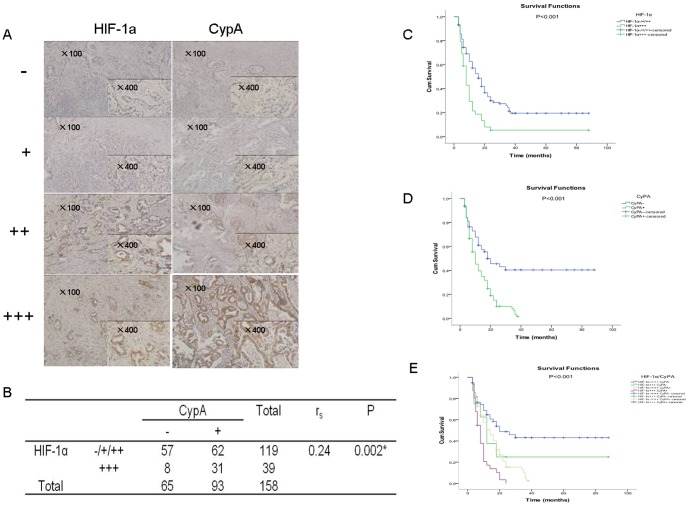
Validation of expression of HIF-lα and CypA in PDAC tissues and analysis of the clinical significance.
A. The IHC results of HIF-lα and CypA. CypA protein expression was significantly correlated with HIF-lα, as detected by immunohistochemical staining on PDAC. Left panels: various expression levels of HIF-lα protein. Right panels: expression of CypA protein of the same samples in the adjacent section. B. Cross tabulation of HIF-lα and CypA expression levels in 158 cases of PDAC. Expression of CypA was correlated with HIF-1α (P = 0.002). C. The survival analysis of HIF-lα IHC results. PDAC patients (n = 158) with mild positive HIF-lα protein expression (−/+/++, n = 119) had significantly better total survival than those with strong positive expression (+++, n = 39). HIF-1α expression was prognostic for overall survival. The two- and three-year survival rates were 25.2% and 13.4%, respectively, in patients with mild HIF-1α, but decreased to 7.7% or 2.6%, respectively, in patients with strong expression of HIF-1α. (P<0.001) D. The survival analysis of CypA IHC results. The same PDAC patients (n = 158) with negative CypA protein expression (−, n = 65) had significantly better total survival than those with positive expression (+, n = 93). Patients with negative CypA had two- and three-year survival rates of 32.3% and 20%, respectively, which significantly decreased to 12.9% and 4.3% in patients with positive CypA (P<0.001). E. The survival analysis of HIF-lα and CypA IHC results. The same PDAC patients (n = 158) with mild positive HIF-1α and negative CypA protein expression (n = 57) had significantly better total survival than those with strong positive HIF-1α and positive CypA expression (n = 31), the two- or three-year survival rate between them was significantly different, respectively (P<0.001). Besides, the same PDAC patients (n = 158) with mild positive HIF-1α and positive CypA protein expression (n = 62) or with strong positive HIF-1α and negative CypA protein expression (n = 8) had significantly better total survival than those with strong positive HIF-1α and positive CypA expression (n = 31), and had worse total survival than those with mild positive HIF-1α and negative CypA expression (n = 57). The two- or three-year survival rate between the above every combination of two groups was significantly different, respectively (P<0.05).